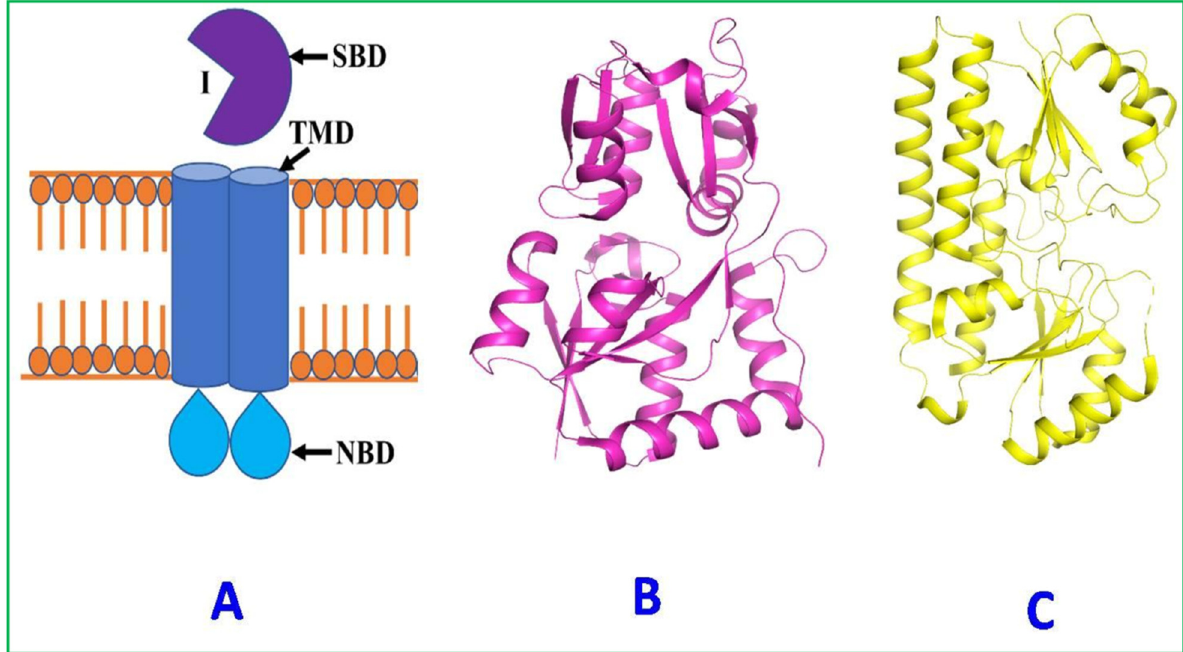
Figure 7. ( A ) Schematic representation of ABC transporter complexes with SBDs in Gram-negative bacteria. ( B ) Crystal structure of periplasmic cystine-binding protein from C Las (PDB Id: 6A80). ( C ) Crystal structure of periplasmic metal-binding protein from C Las (PDB Id: 4Cl2). SBD: Solute-binding domain, TMD: Transmembrane domains, NBD: Nucleotide binding domain.